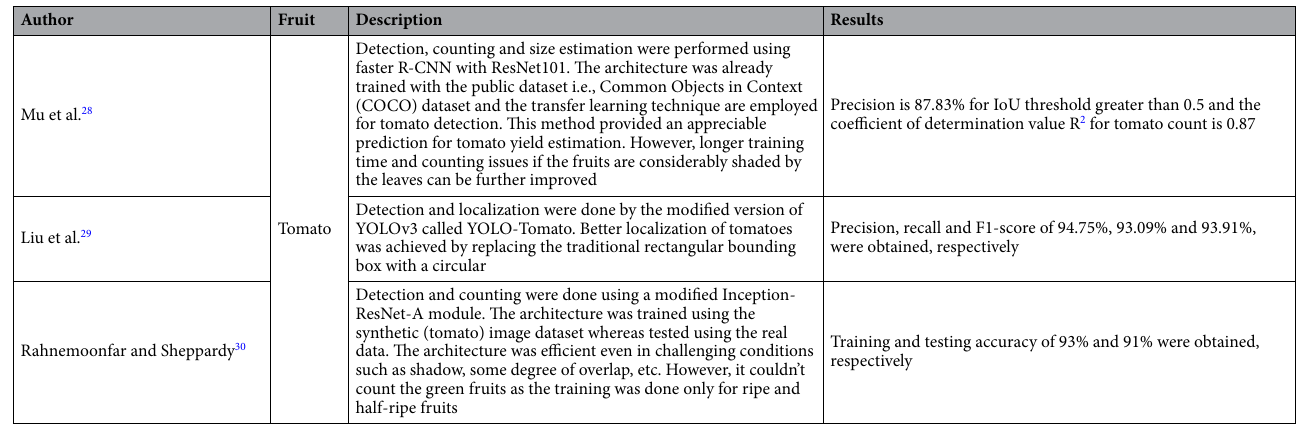
Table 2. Literature for the YE of tomato fruit using DL-based semantic